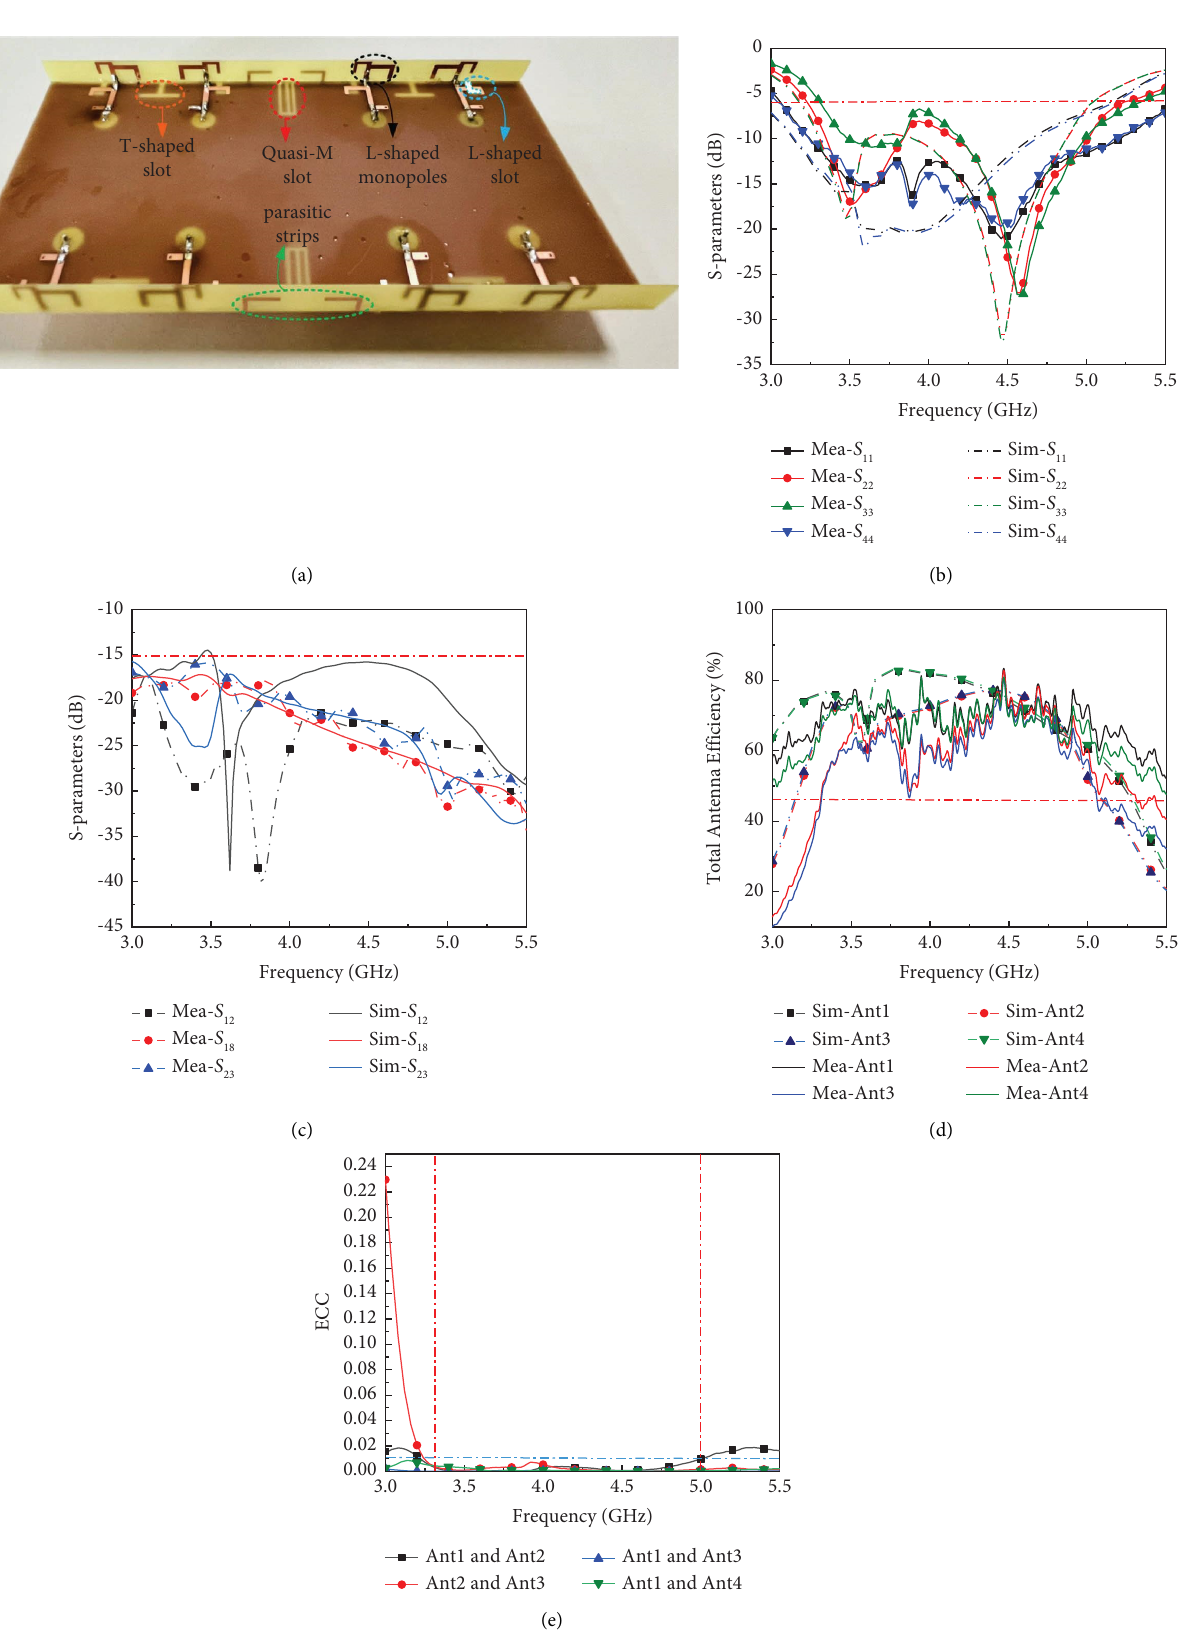
Figure 11: Prototype and measurement: (a) prototype of the proposed antenna system; (b) S -parameter simulation and measurement of the proposed antenna system; (c) isolation simulation and measurement of the proposed antenna system; (d) total efciency simulation and measurement of the proposed antenna system; (e) calculated ECC of the proposed antenna